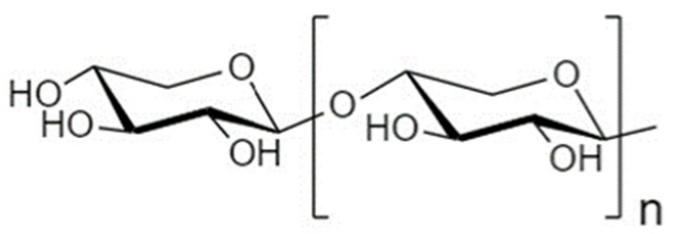
Figure 8. XOS structure: the main components of XOS are n 1,4-linked β - D -xylose monomers. XOS, xylooligosaccharides.